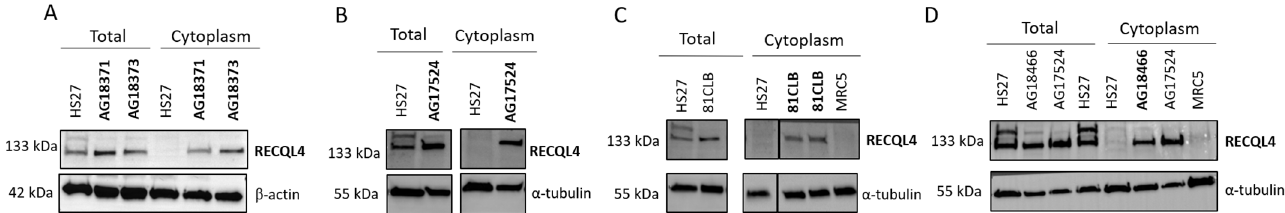
Figure 7. Subcellular localization of the RECQL4 protein in RTS fibroblasts. ( A – D ). Anti- RECQL4